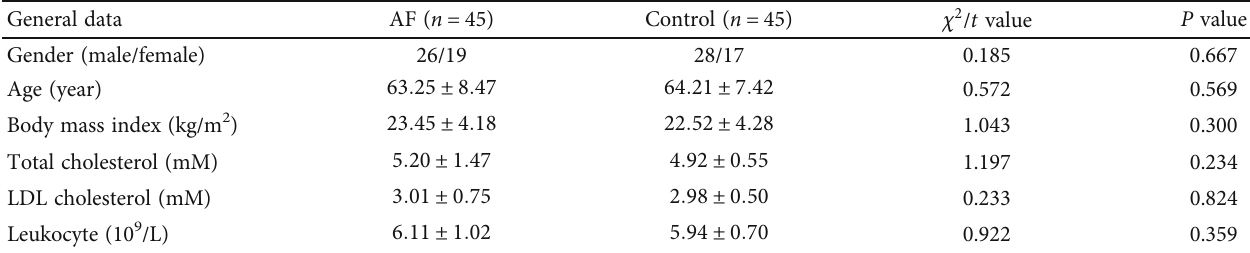
Table 1: Comparison of general data between the two groups.